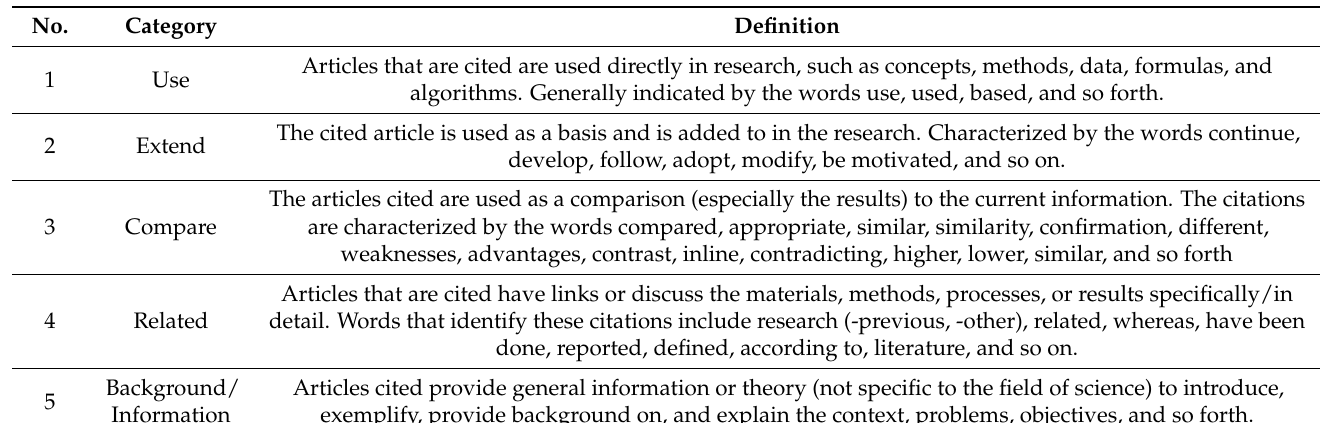
Table 3. The proposed citation function classification scheme for the Indonesian journal dataset.